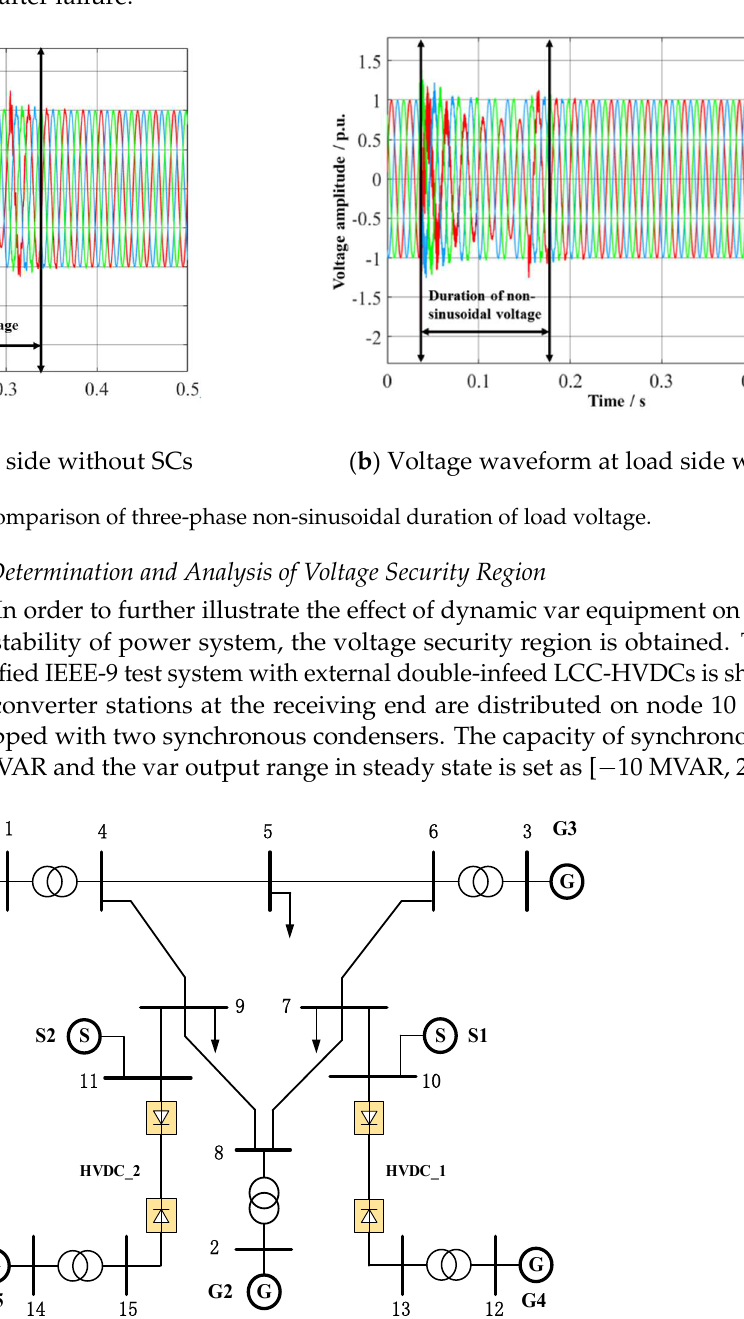
Table 4. Comparative chart of electrical losses.